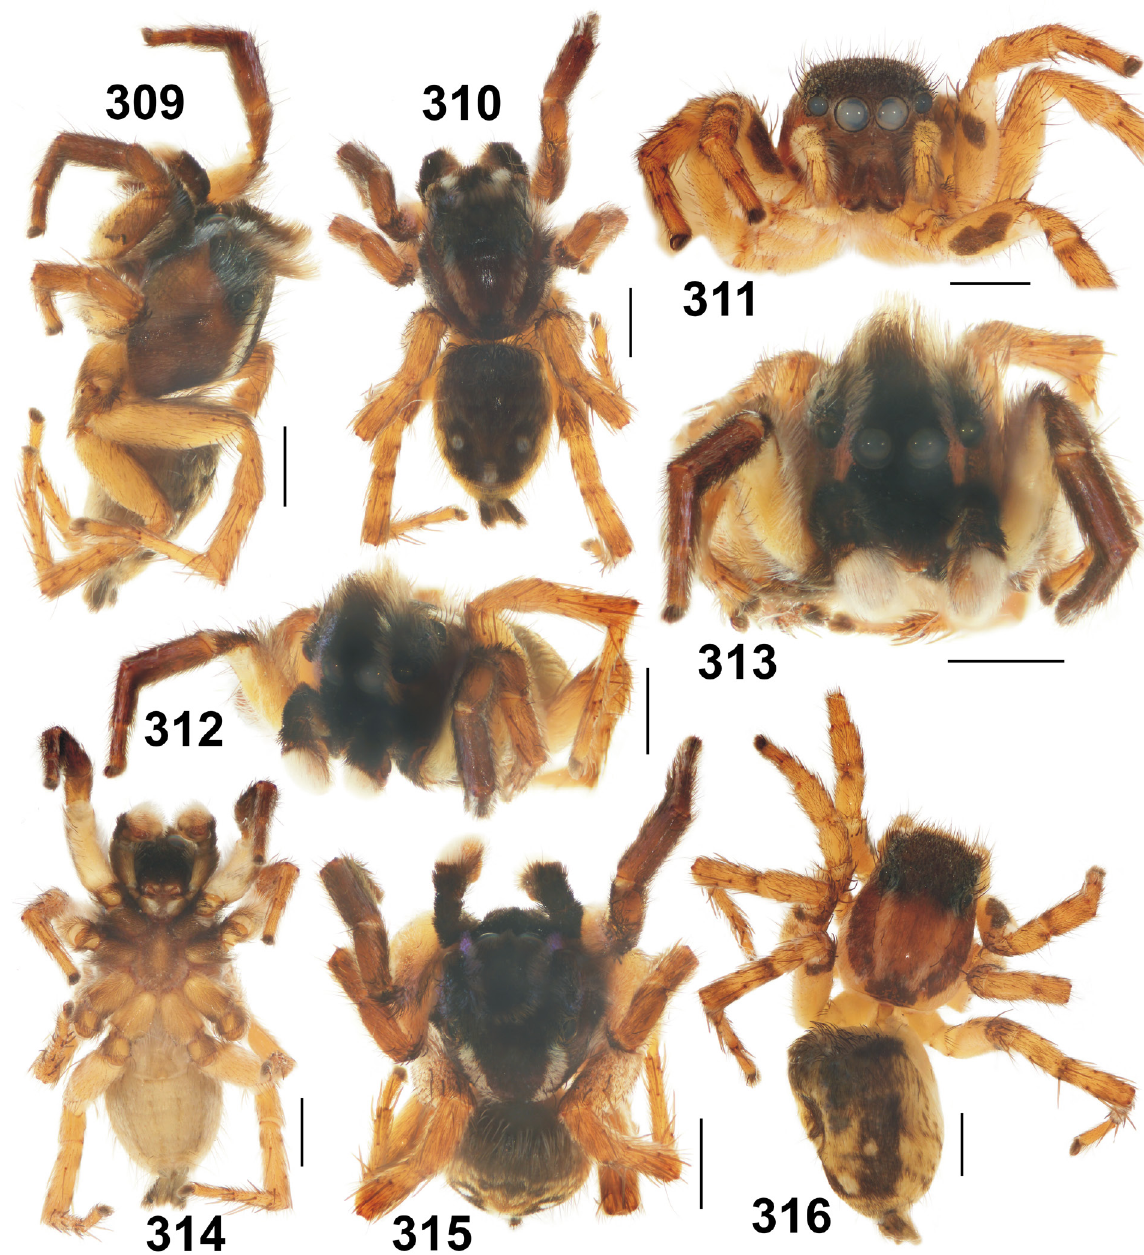
Figs 309–316. Stenaelurillus jocquei sp. nov., paratypes from Cameroon (Rumsiki), dark form. 309– 310 , 312–315 . ♂. 311 , 316 . ♀. Scale bars: 1